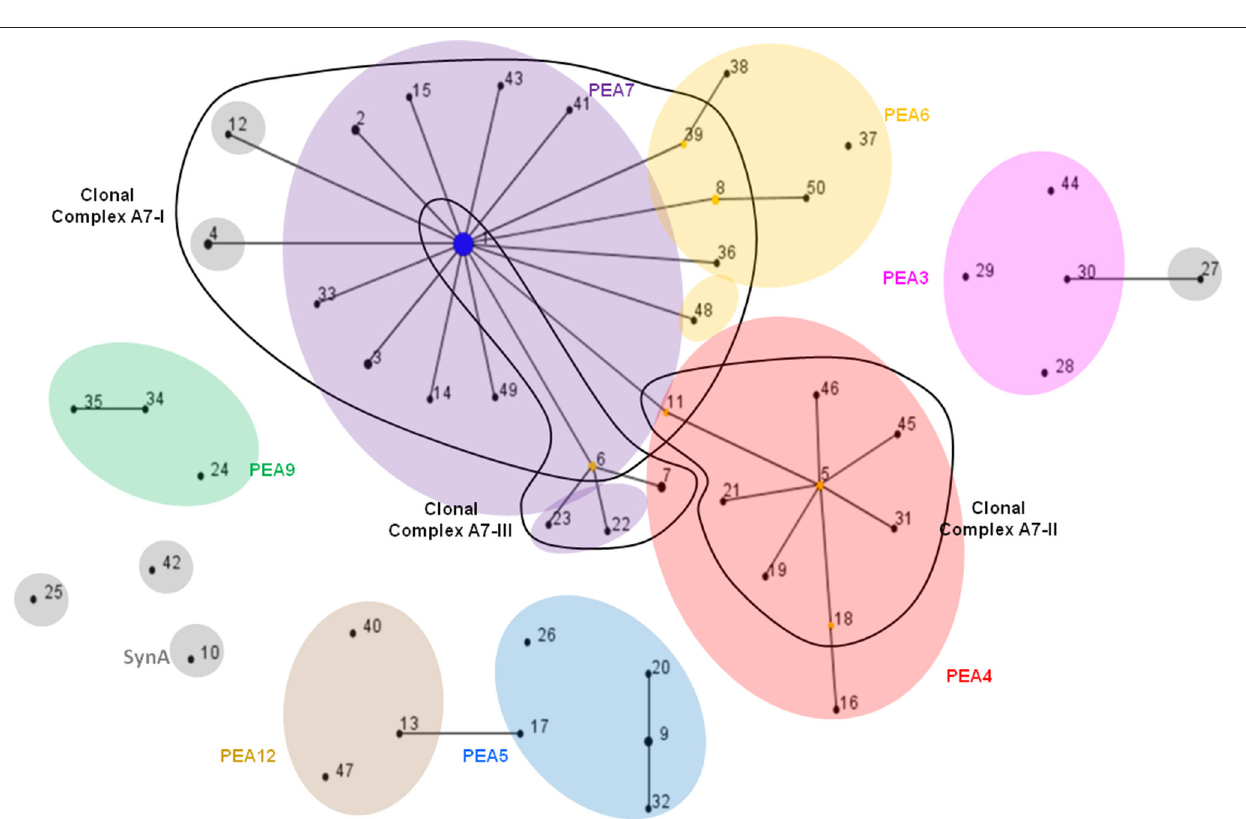
FIGURE 4 | eBURST population snapshot of A-like Synechococcus BACs for the 7-locus analysis shown in Figure 2A. Clonal complexes enclosed by solid black lines. PE demarcation from Ecotype Simulation analysis are overlaid, using different colors corresponding to Figure 2A to represent distinct PEs. STs are represented by numbers and those colored in gray belong to PEs demarcated from a single sequence with a unique ST. Reference genome indicated by “SynA” next to ST10.